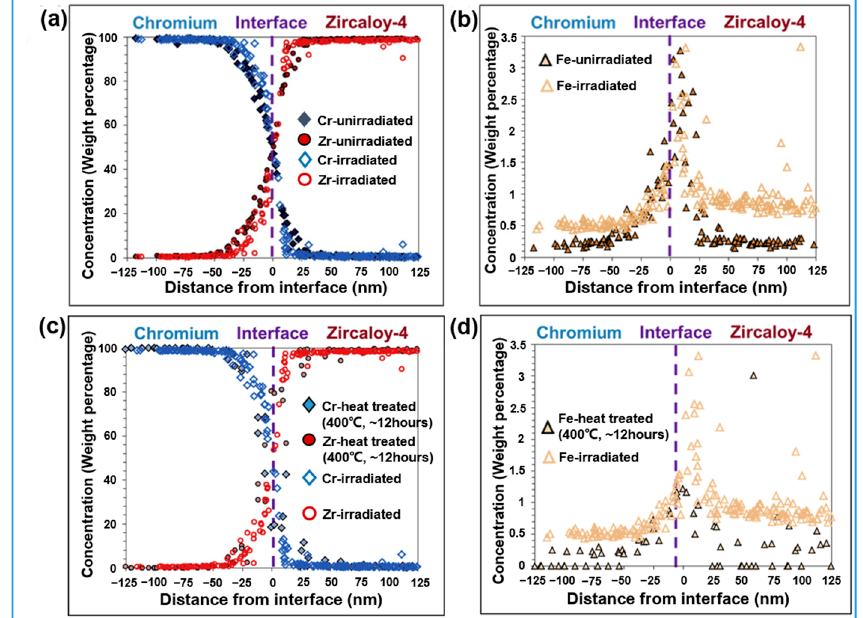
Figure 5. Impact of ion-irradiation on the chemical composition at the Cr/Zr interface: concentration distribution of Cr, Zr ( a ) and Fe ( b ) before and after irridiation; comparisons between heat-treated and irridiated samples in the concentration distribution of Cr, Zr ( c ) and Fe ( d ), respectively. Reproduced from the work in [24] with copyright permission from Elsevier.